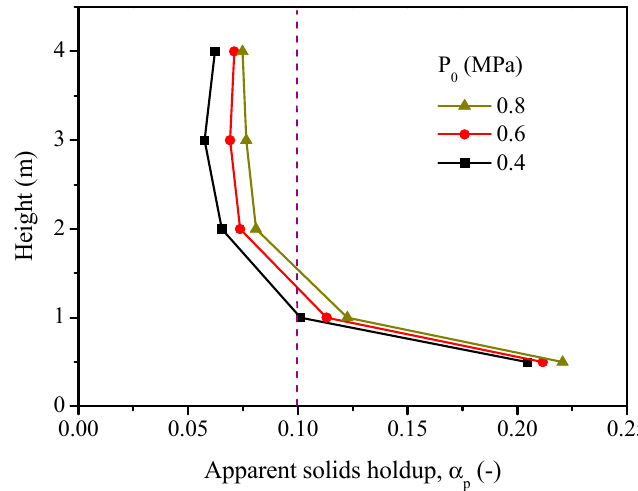
Figure 13. Effect of operating pressure on the profile of the solids holdups along the reactor height.